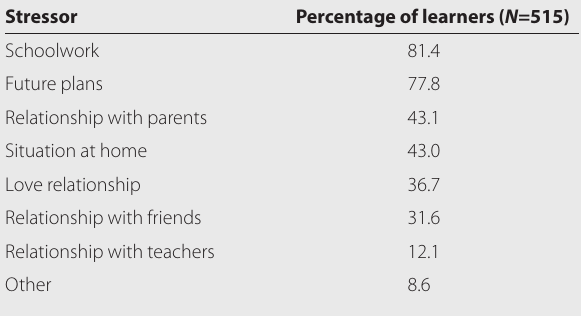
Table 3. Stressors identified by Grade 11 and 12 learners as sources of anxiety and